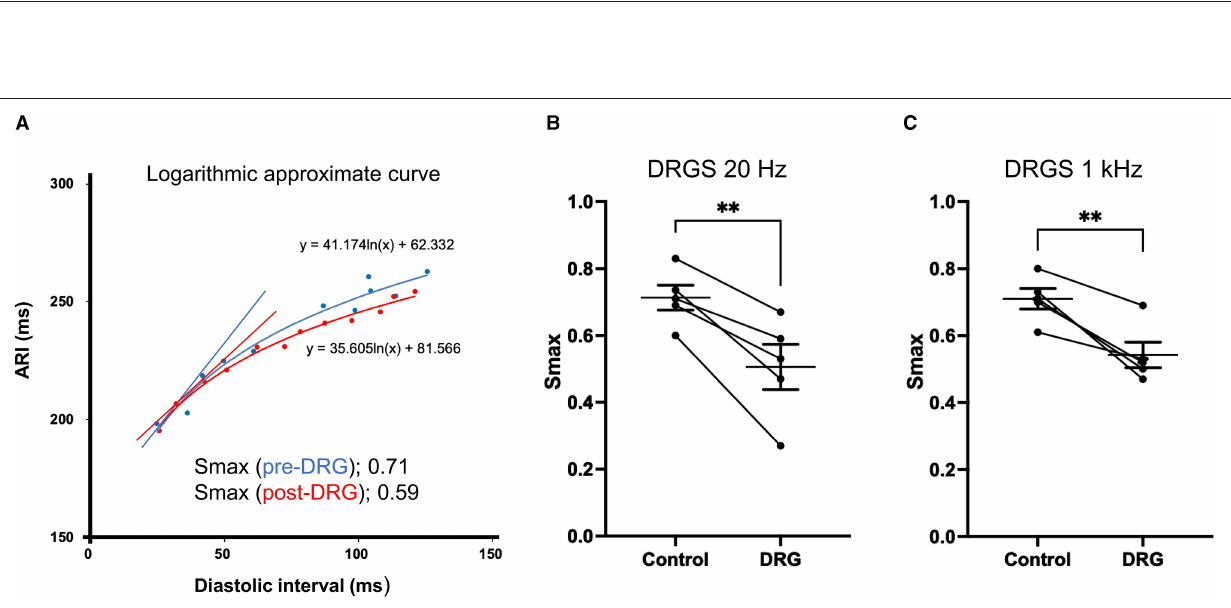
Frontiers in Physiology |